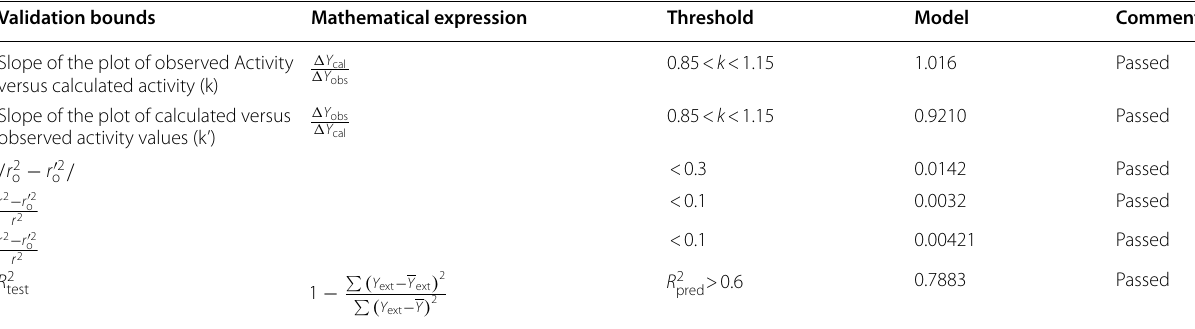
Table 8 External validation Validation bounds Mathematical expression